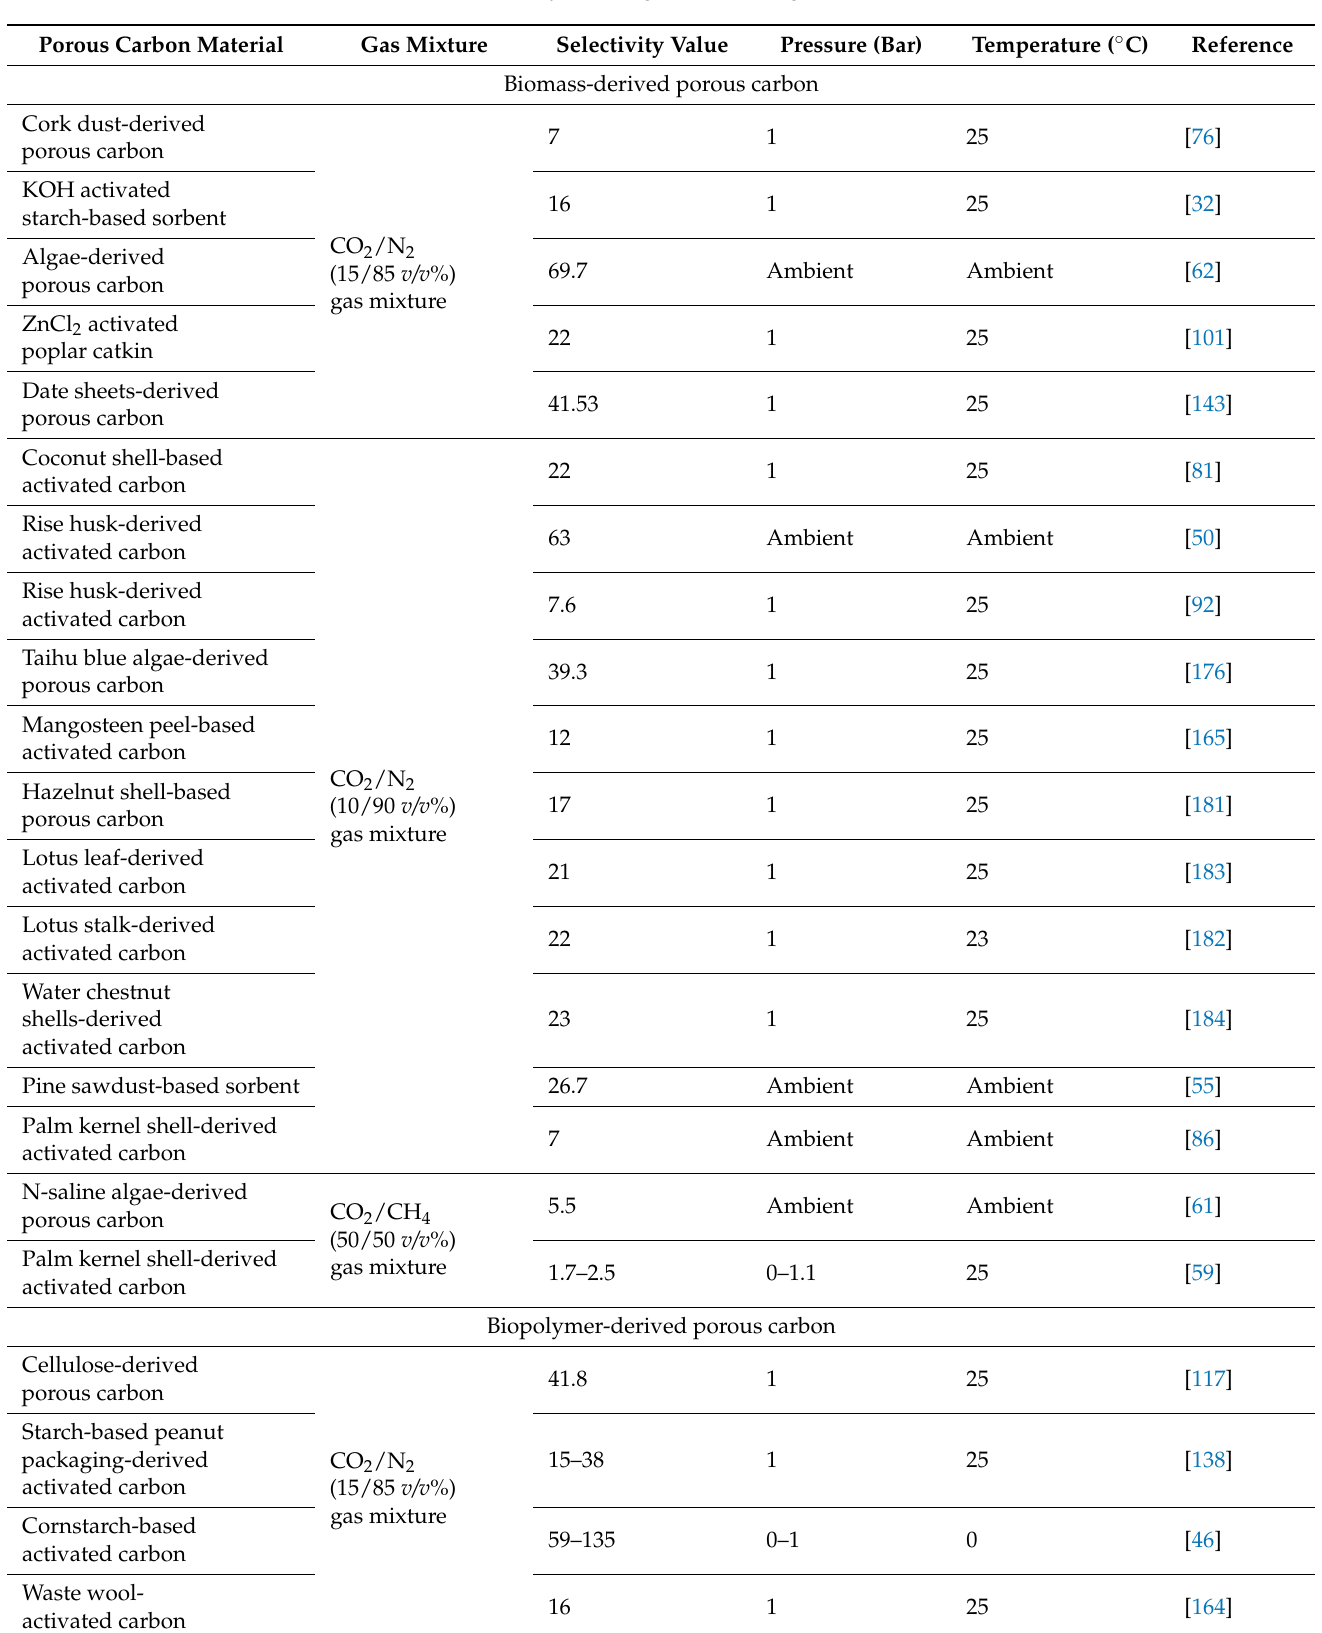
Table 9. The selectivity of CO 2 gas over other gases for various carbon